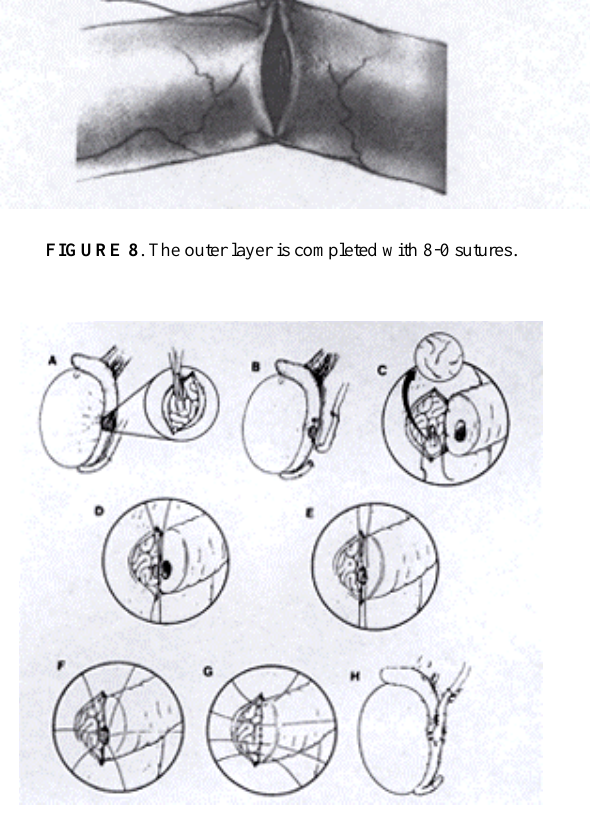
FIGURE 9 . Method of "end-to-side" single tubule vasoepididymostomy. (Modified from Thomas, A.J., Jr.,